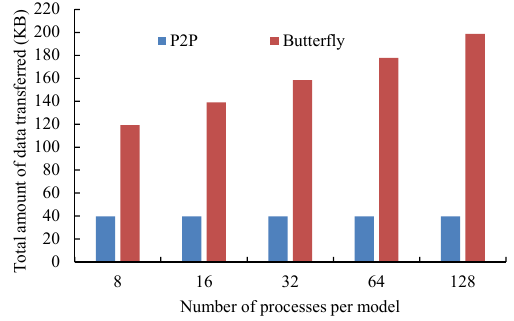
Figure 8. Total amount of data transferred by P2P implementation and butterfly implementation ( y axis) in GAMIL2–CLM3, when varying the number of processes per model ( x axis). The experi- mental set-up is similar to that shown in Fig. 1.